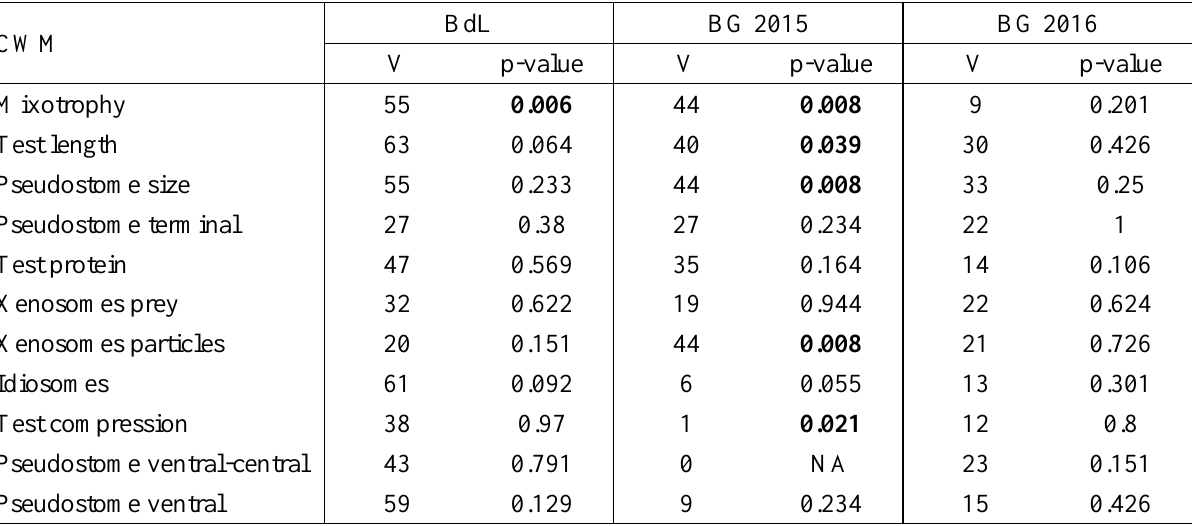
Table A2. Wilcoxon rank test (V) for each functional trait between living and dead testate amoeba assemblages in the Neuchâtel Botanic Garden experimental peatland (BG 2015 and BG 2016) and Bois-des-Lattes reference site (BdL). Significant p-values (< 0.05) are shown in bold type.